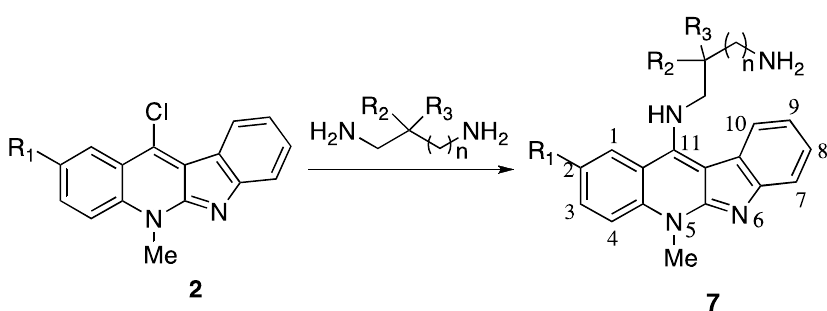
Table 4. Antiproliferative activity of 11-aminoalkylamino-5-methyl-indolo[2,3- b ]quinolines against cell lines of MV4-11, A549 and HCT116, and cytotoxicity against normal mice fibroblast BALB/3T3 [15].